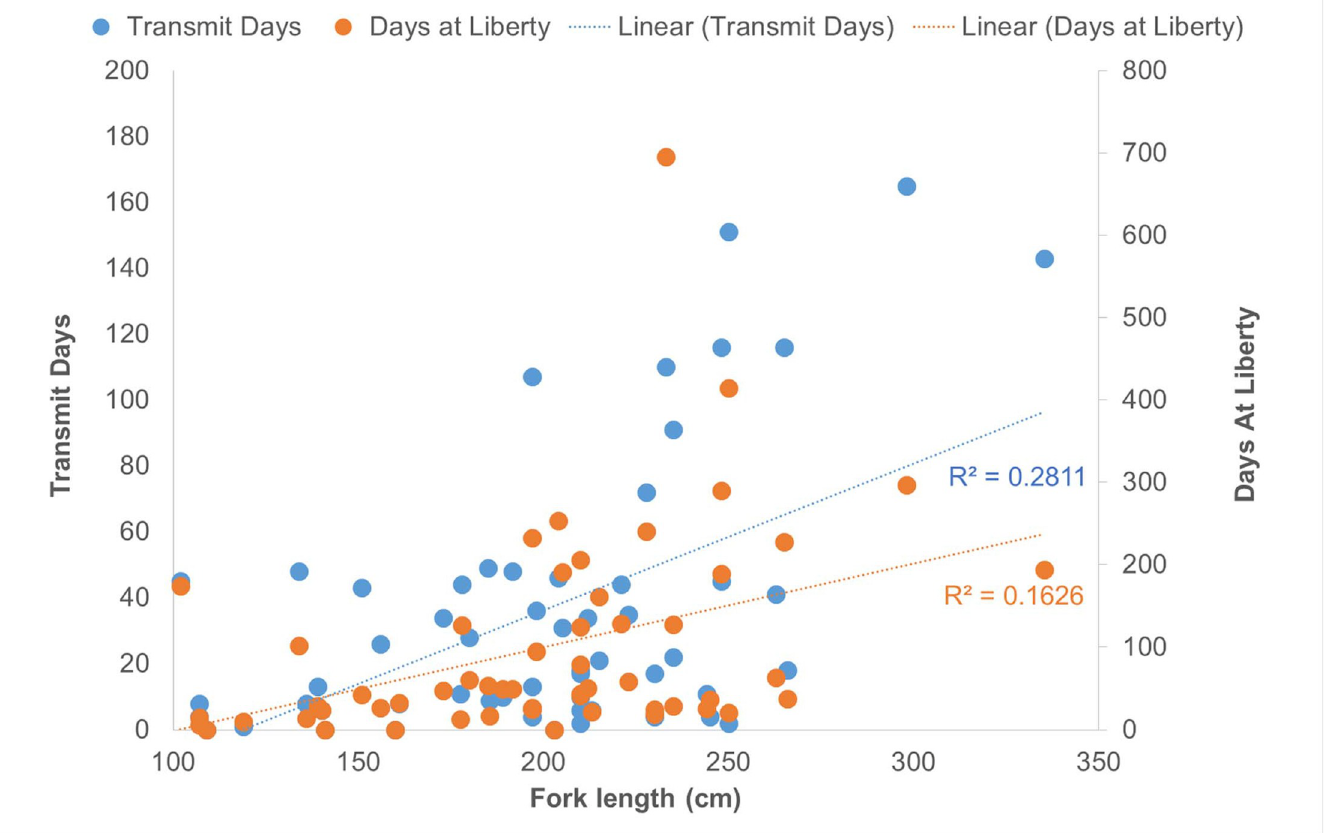
Fig 2. Scatterplot of track duration by shark size. Data are presented by transmit days (left axis, blue dots) and days at liberty (right axis, orange dots) by fork length (FL, cm). Linear regressions and r-squared values are indicated by dashed lines.